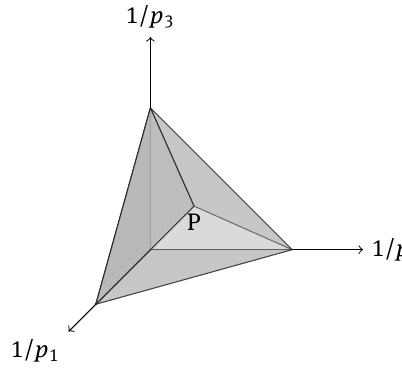
Figure 1: The conjectured sharp region R , where P = (1/2, 1/2, 1/2) .